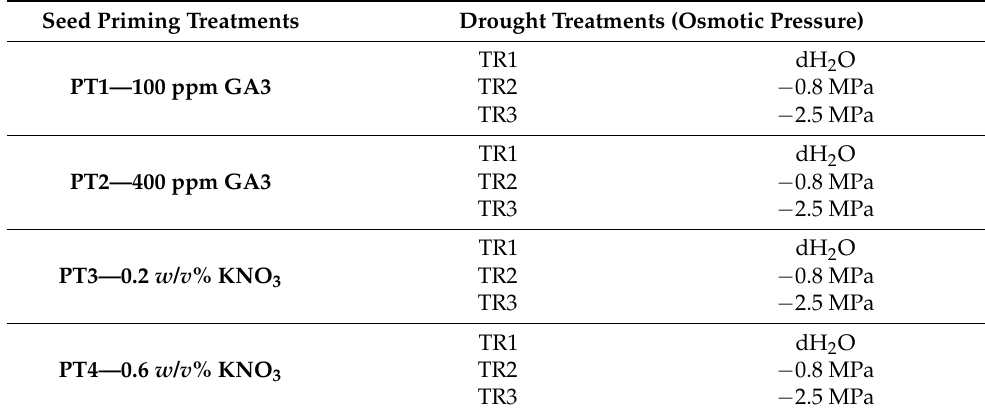
Table 2. Combination of seed priming treatments and the osmotic pressure in drought treatment solu- tions in the second phase of the experiment of the seed germination of winter savory Population 1 (P1). Seed Priming Treatments Drought Treatments (Osmotic Pressure) PT1—100 ppm